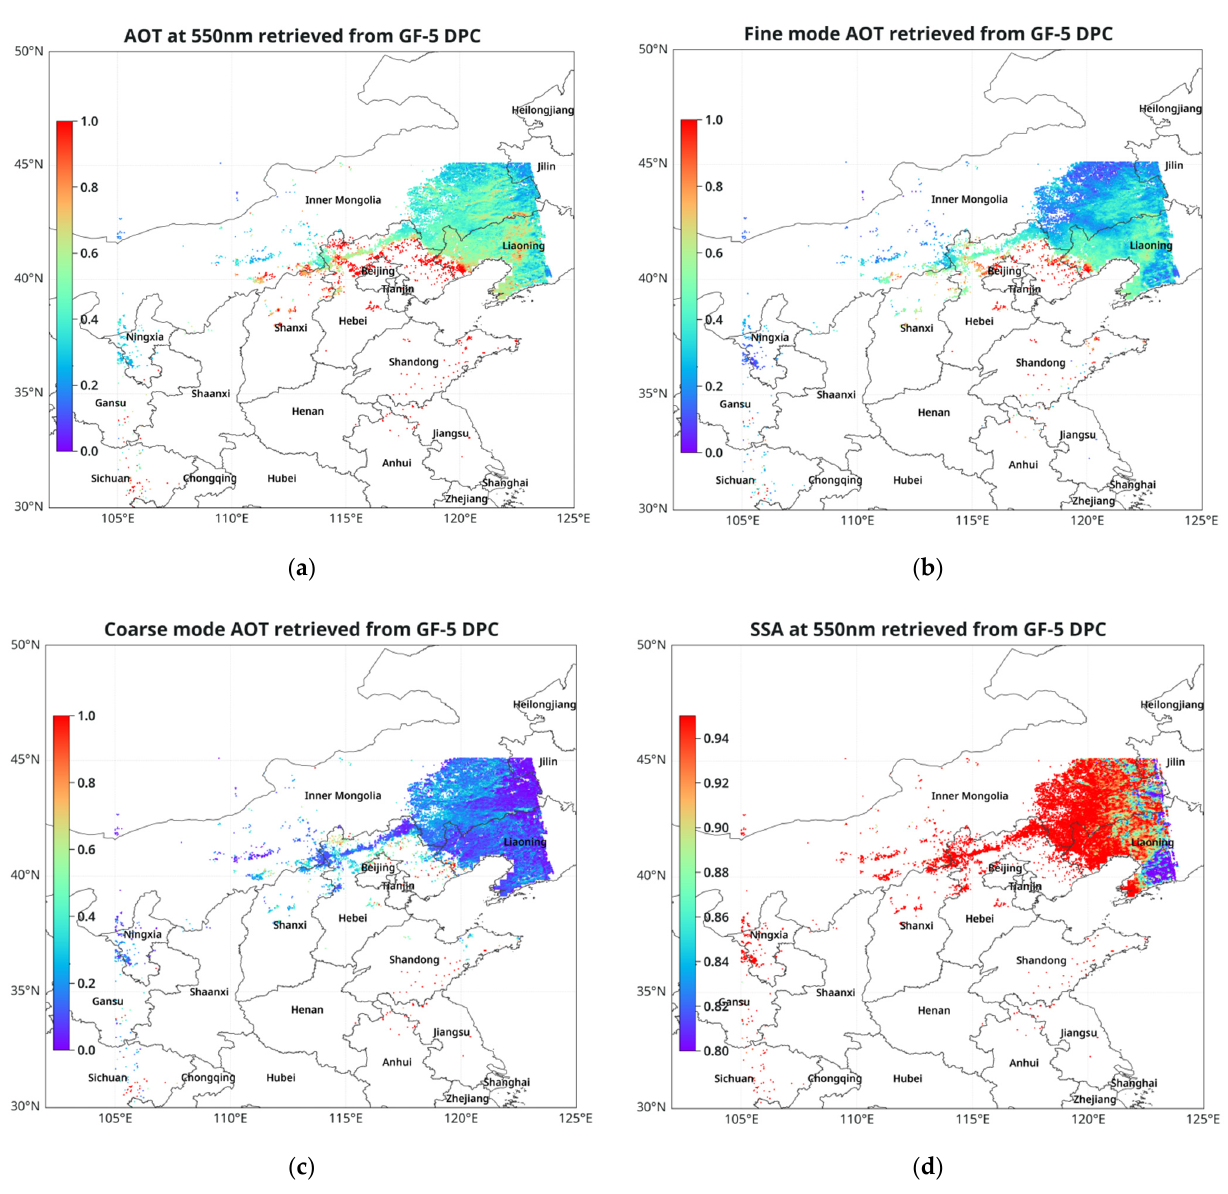
Figure 11. The aerosol retrievals with DPC over northeast China on 6 February 2020, including